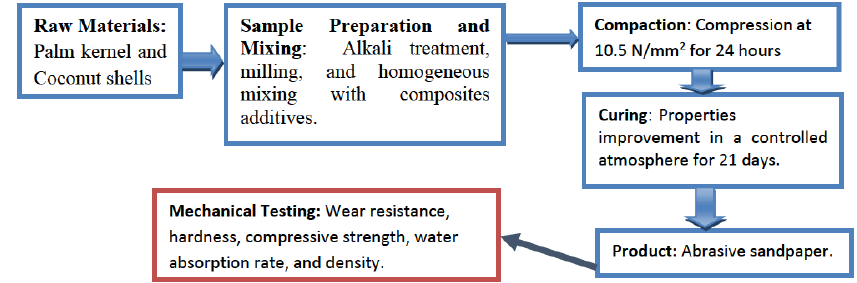
Figure 1: Procedural steps followed for abrasive sandpaper